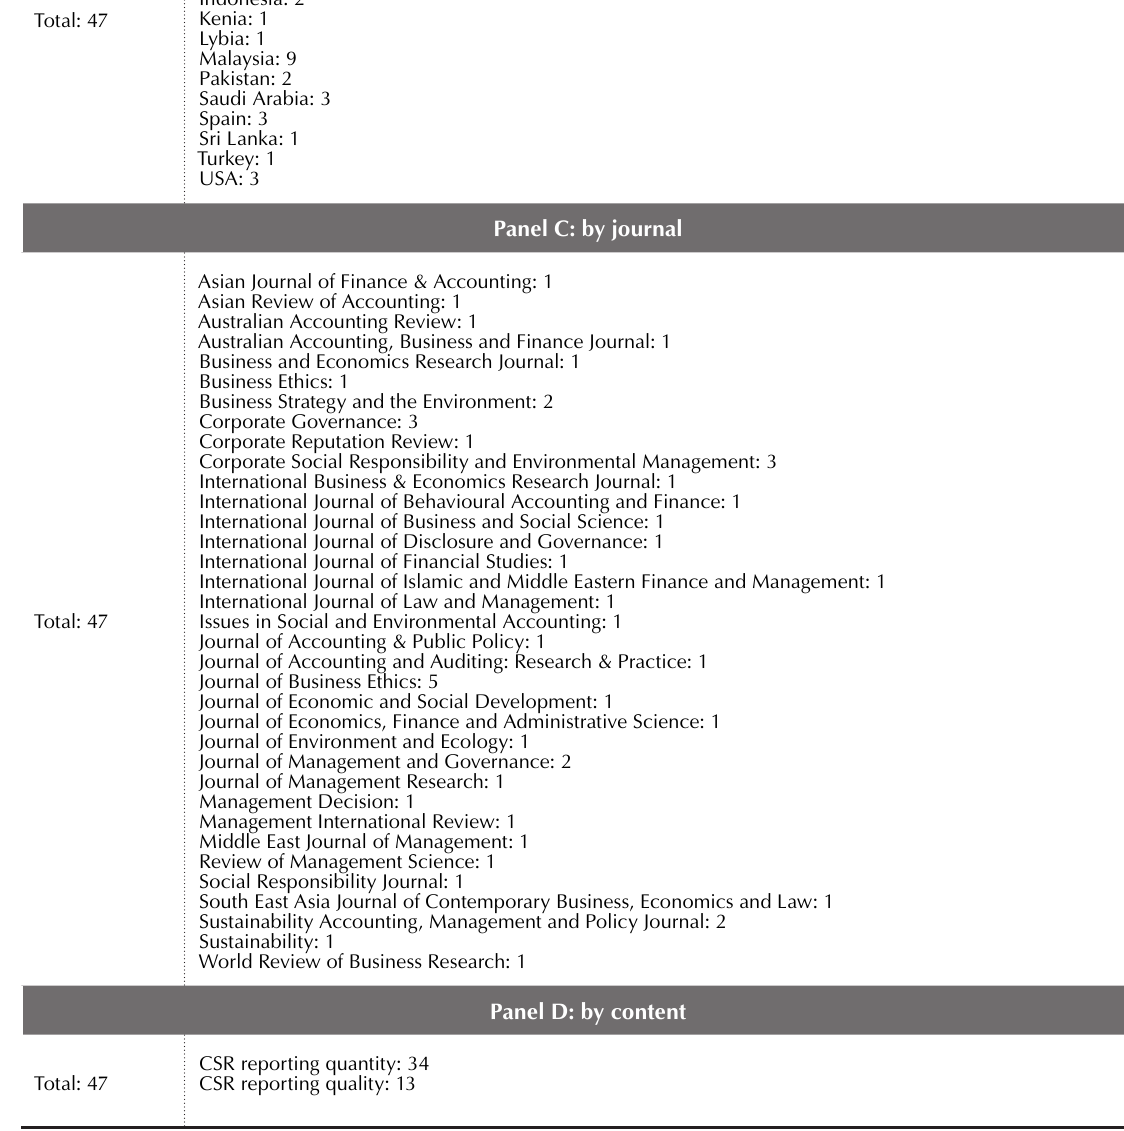
Panel A: by publication